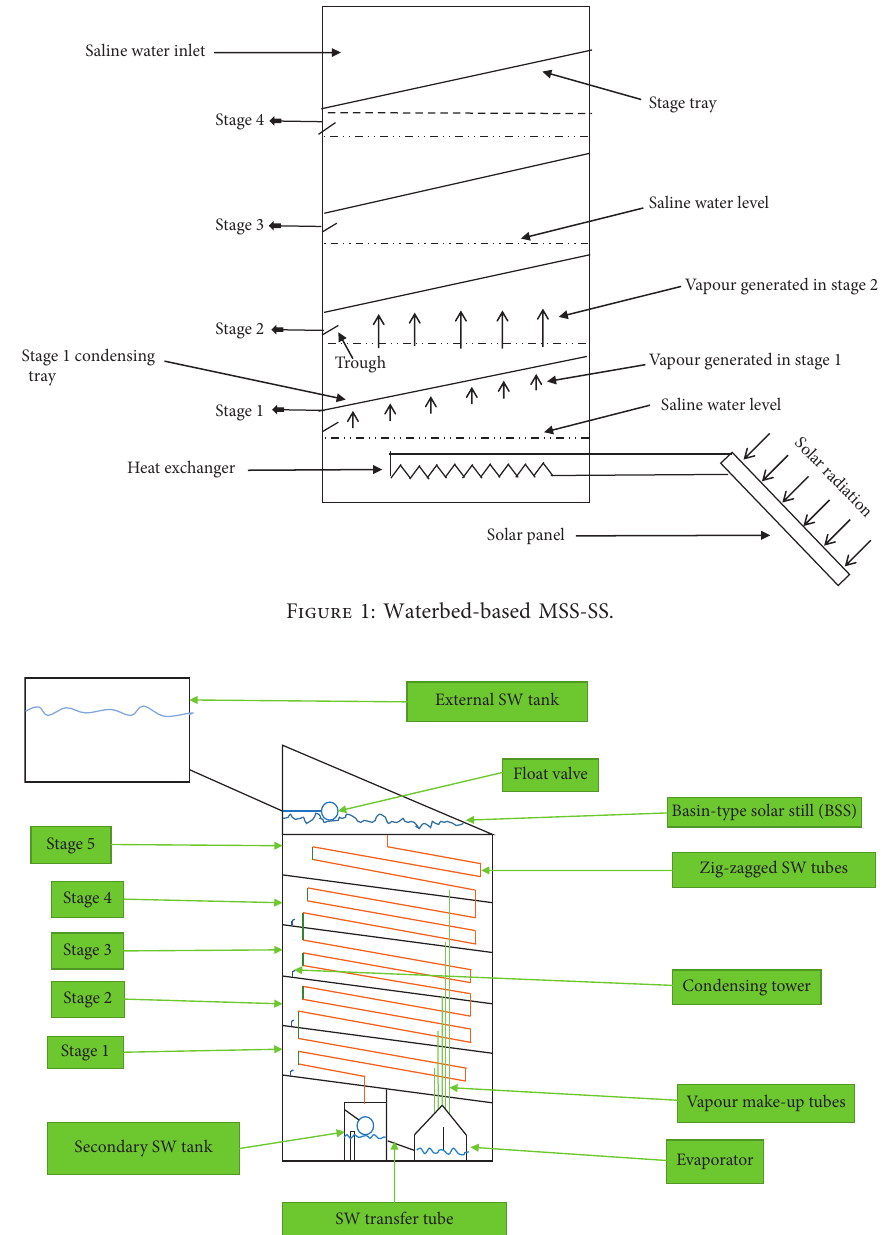
Figure 2: Vapour-based MSS-SS integrated with the BSS.